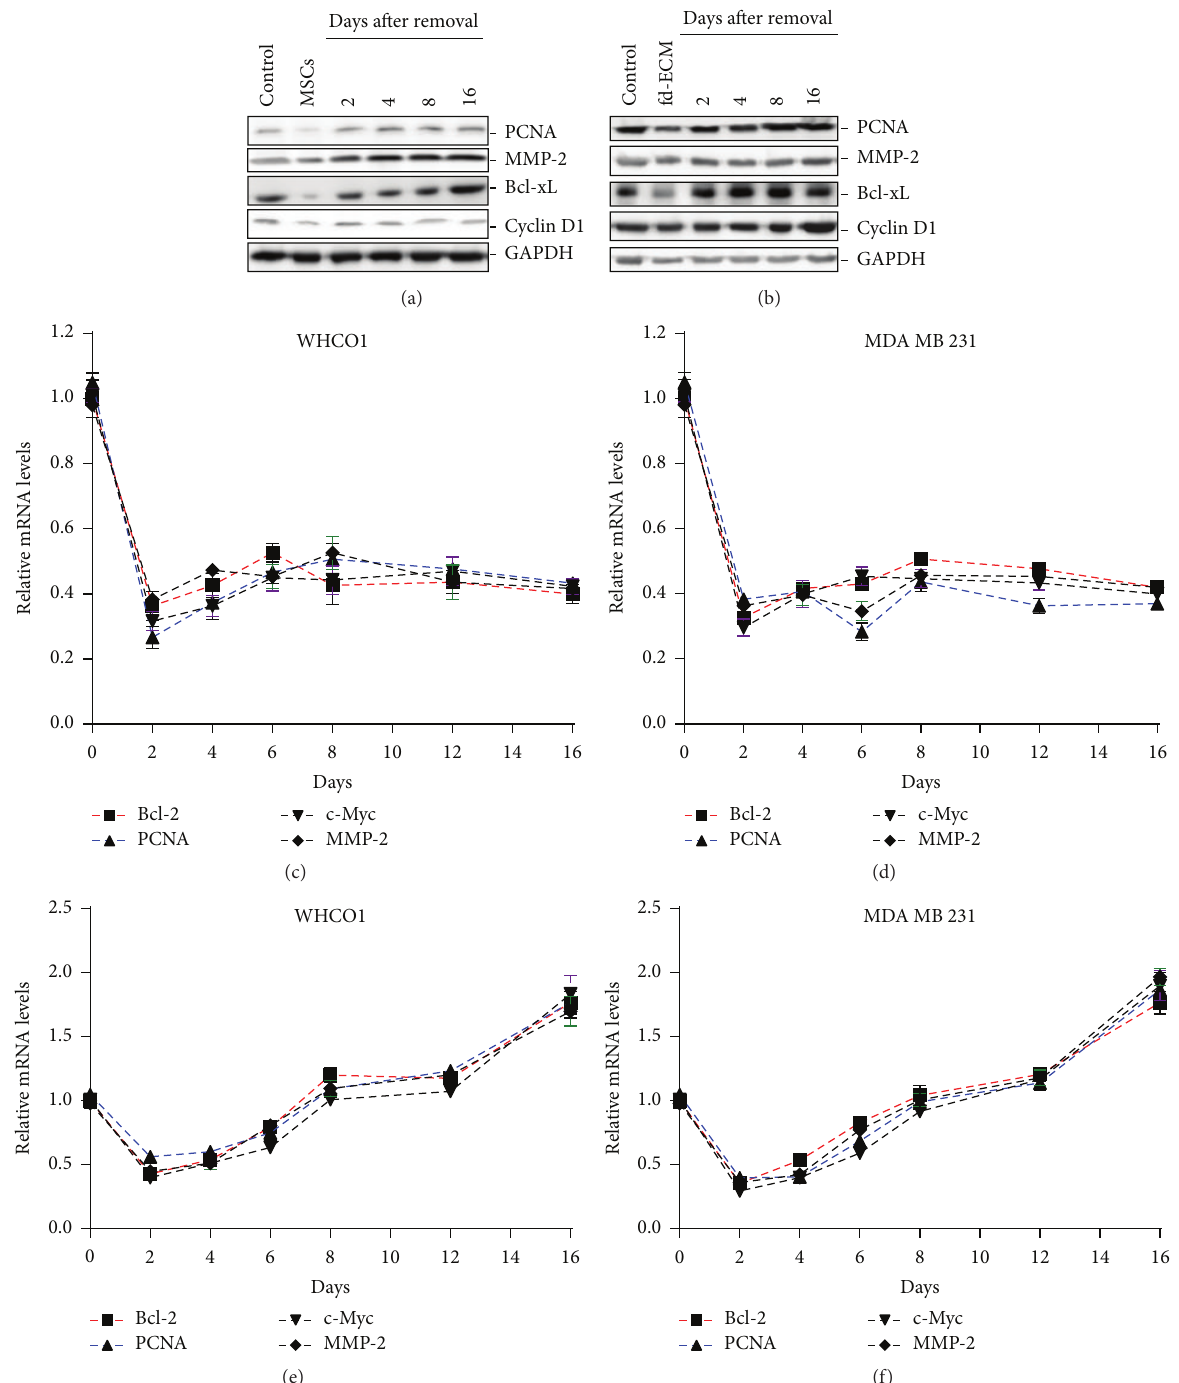
Figure 8: WHCO1 cells are able to recover from the effect of both MSCs and the fd-ECM. (a) Western blot analysis of WHCO1 lysates using antibodies against PCNA, MMP-2, Bcl-xL, and cyclin D1. WHCO1 cells were cocultured with MSCs followed by a 16-day recovery